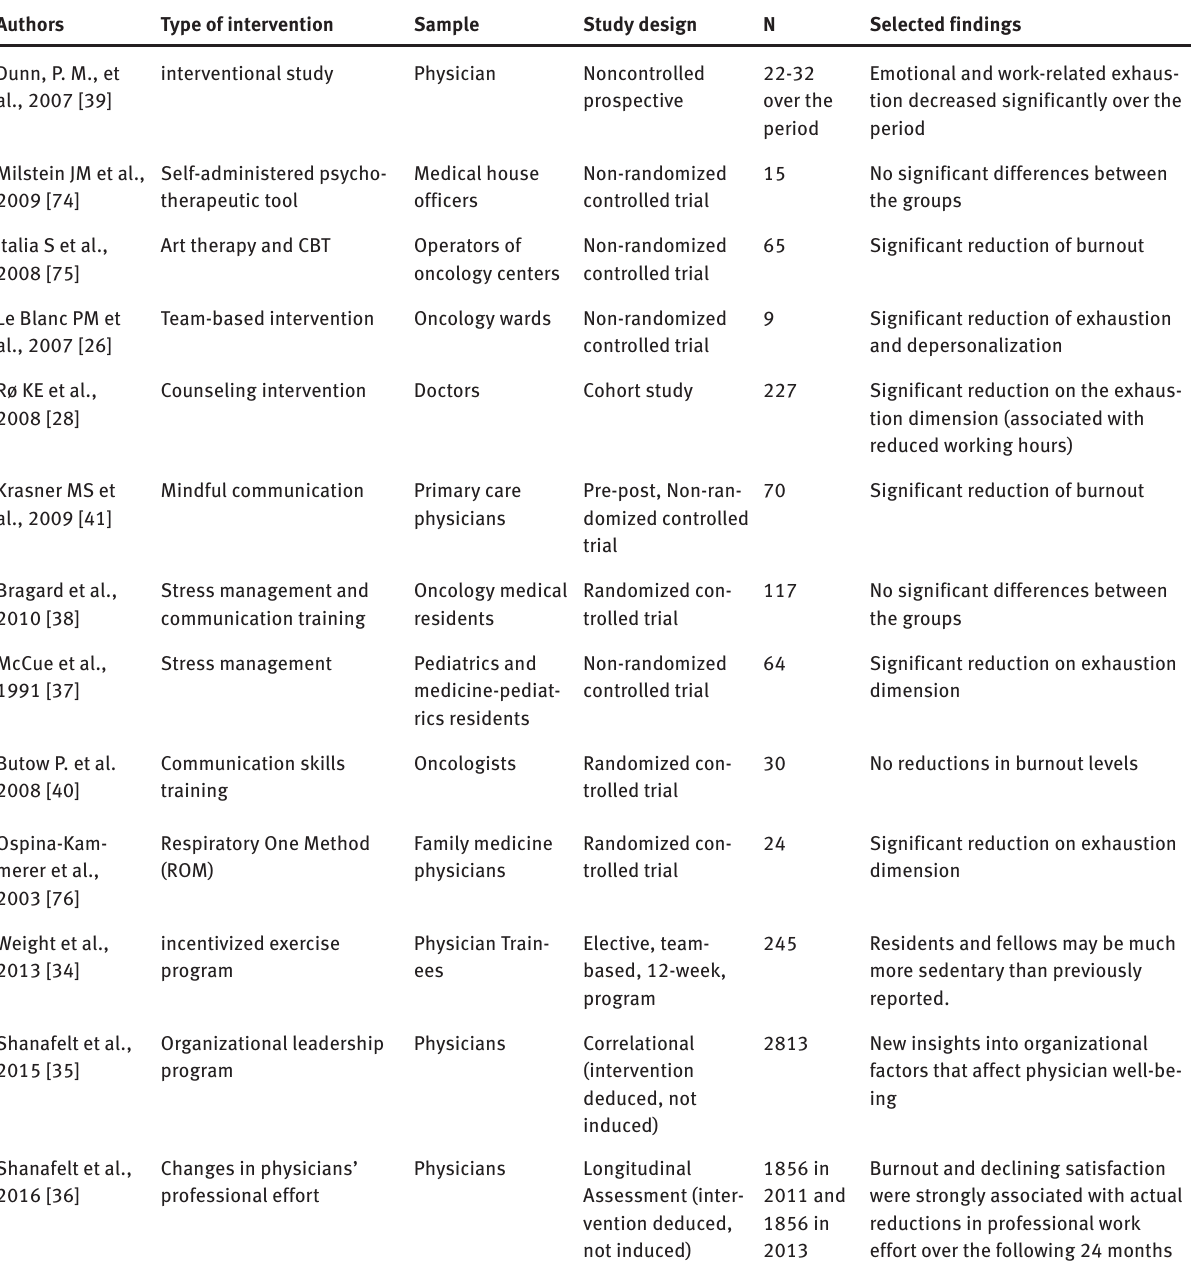
Table 1: Methodological characteristics, demographic information, and main results for studies on the treatment of physician burnout.